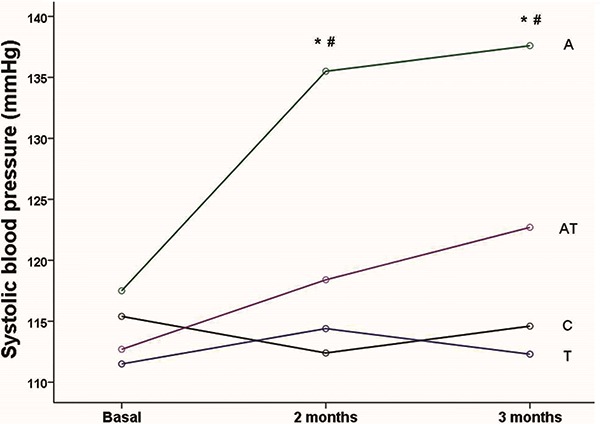
Effect of nandrolone decanoate (A), taurine (T) and their combination (AT)
on systolic blood pressure (SBP) of rats. There was a significant increase of
SBP at 2 and 3 months vs basal SBP only in the A group. SBP
was significantly higher in the A vs control (C) group and
also in the A vs AT group (n=8 for each group), at 2 and 3
months (General Linear Model; repeated measures; and Bonferroni's post
hoc test). *P≤0.002 vs basal blood
pressure;#P≤0.007 vs the C and AT
groups.